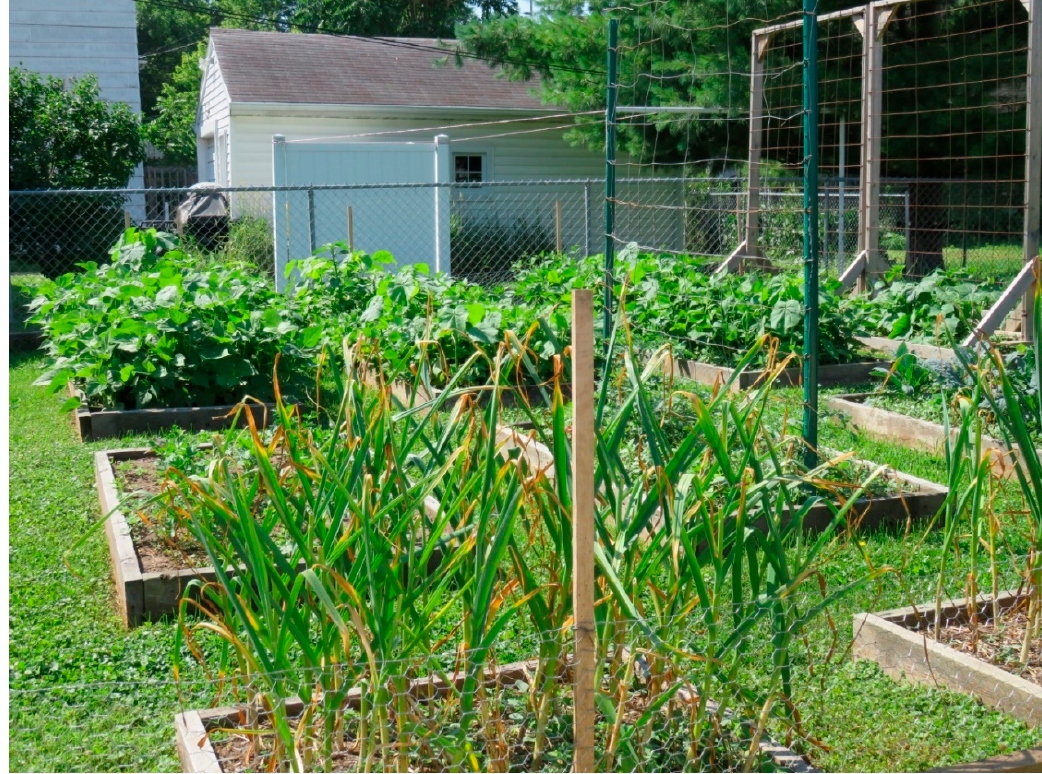
Figure 1. Backyard raised bed garden in the North End neighborhood.